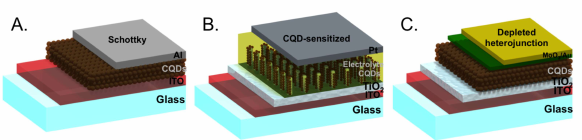
Fig. 2. Schematics of different CQD solar cell architectures employ- ing: (A) a Schottky junction, (B) CQDs as sensitizers, (C) a depleted